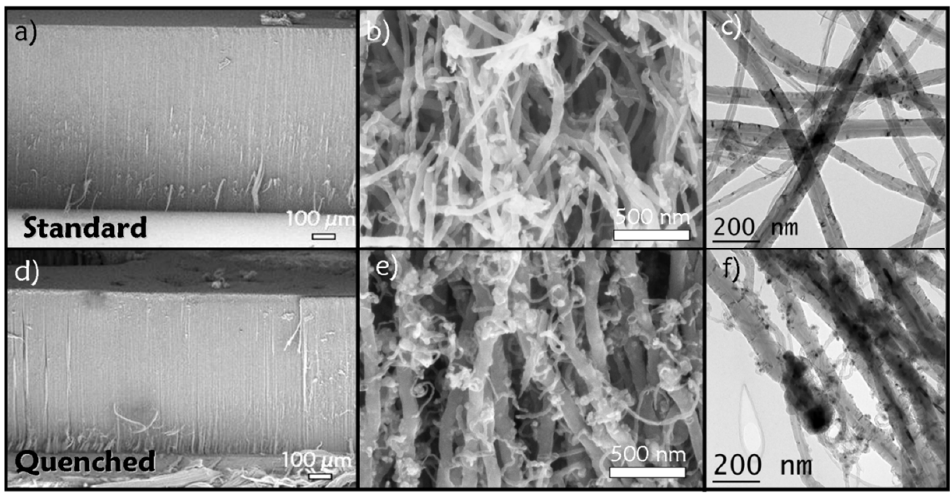
Figure 2 . ( a , b , d , e ) SEM images and ( c , f ) TEM images of CNTs grown from toluene and ferrocene aerosol mixture with the standard ( a – c ) and quenched cooling down procedure ( d – f ). ( a , d ) corre- sponding to the cross-section of the CNT carpet, ( b , e ) to the higher magnification in the top part of the cross-section of the carpet, ( c , f ) to CNTs dispersed on TEM